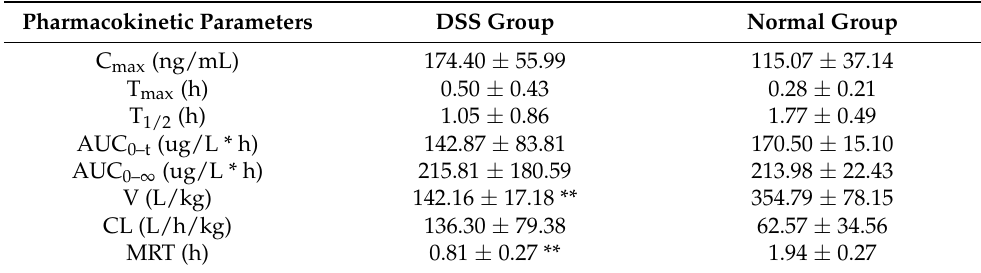
Table 1. Pharmacokinetic parameters of M10 in DSS-group mice and normal-group mice after oral administration of M10 at a dose of 50 mg/kg (mean ± SD, n =